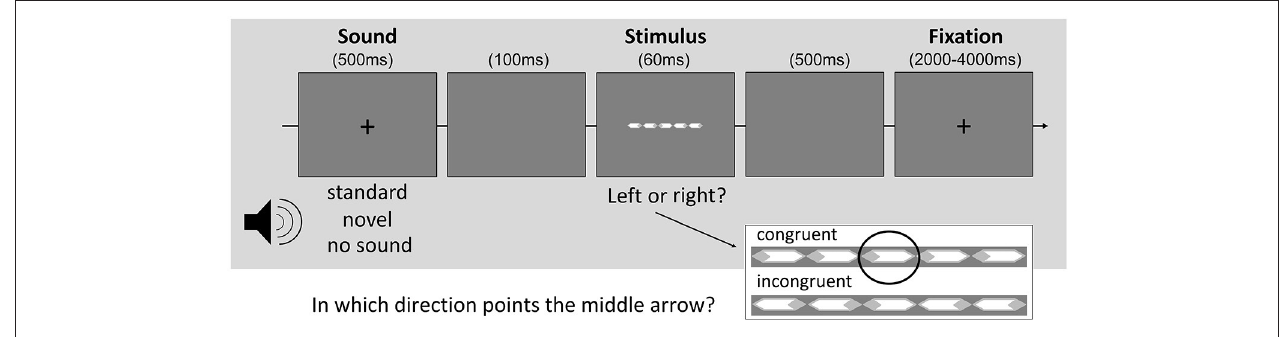
FIGURE 1 | Illustration of the cued flanker